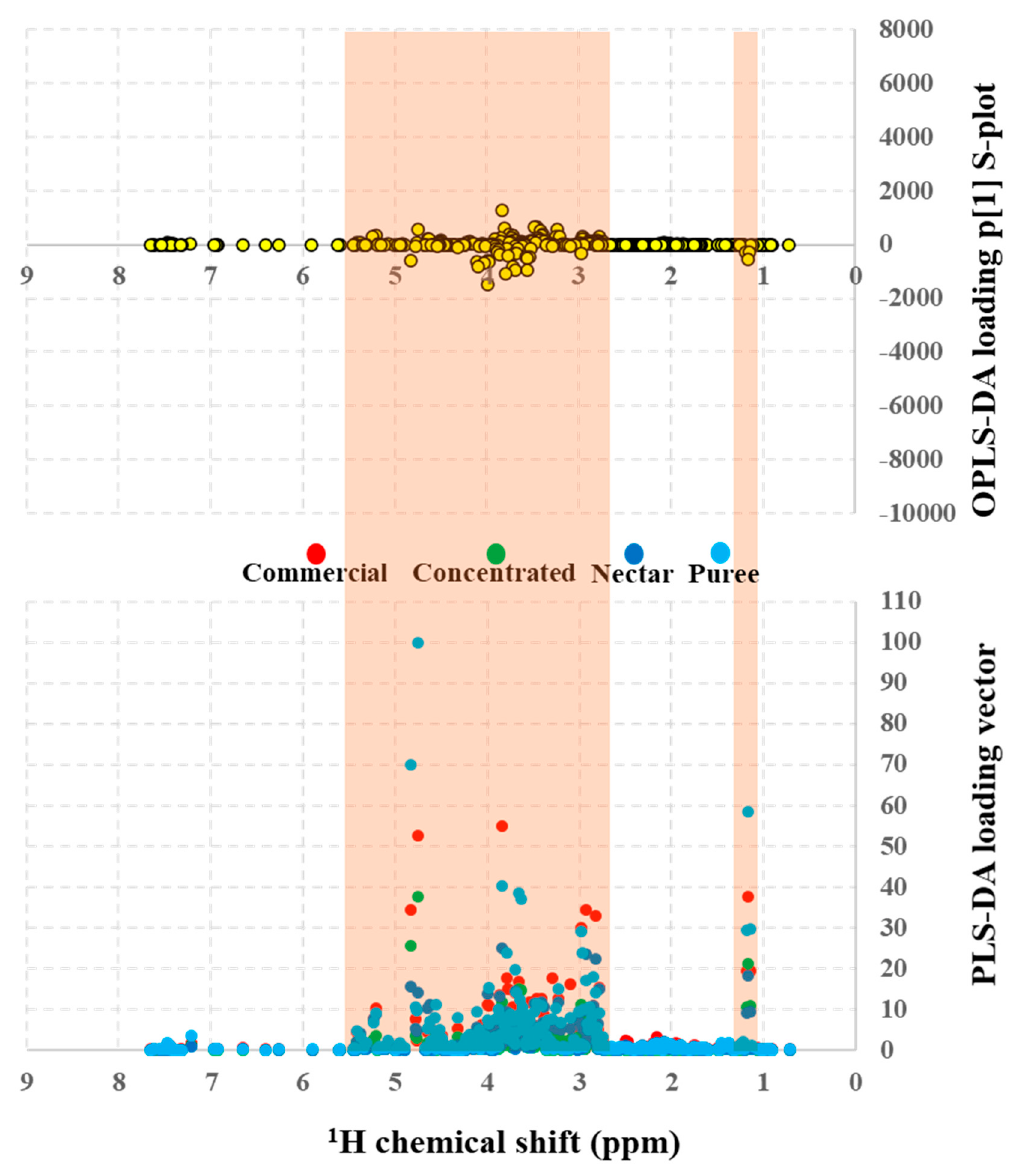
Figure 7. OPLS-DA loading p [1] S-plot ( top ) and PLS-DA loading vectors ( bottom ) as a function of { 1 H water_presat NMR} chemical shifts from the commercial nonconcentrated juice (red); concentrated juice (green); nectar (blue); and puree (cyan) fruit drinks (apple, apricot, and orange) supervised discriminant analysis (Figure 5B,D) that indicates the importance of relevant metabolites used for “type of juice” discriminations.